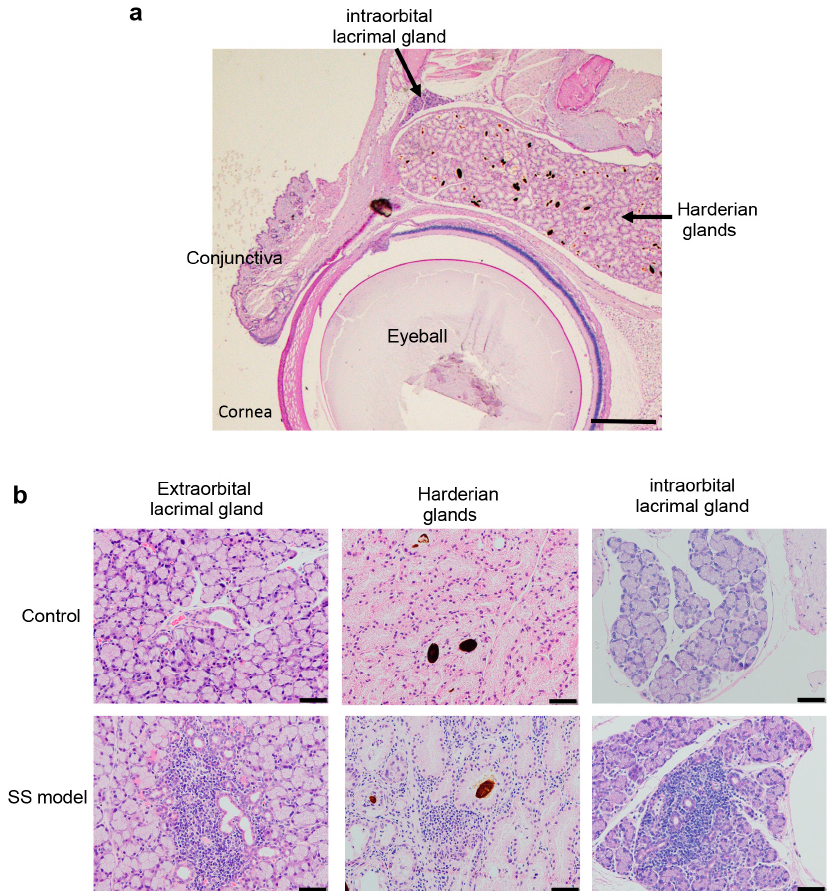
Figure 4. Intraorbital tissues of SS model mice. ( a ) Histological structure of the intraorbital tissues of control mice. Scale bar: 1 mm; and ( b ) Inflammatory lesions in the extraorbital lacrimal glands, Harderian glands, and intraorbital lacrimal glands are shown. Photos are representative of eight mice in each group. Scale bar: 50 μ m.